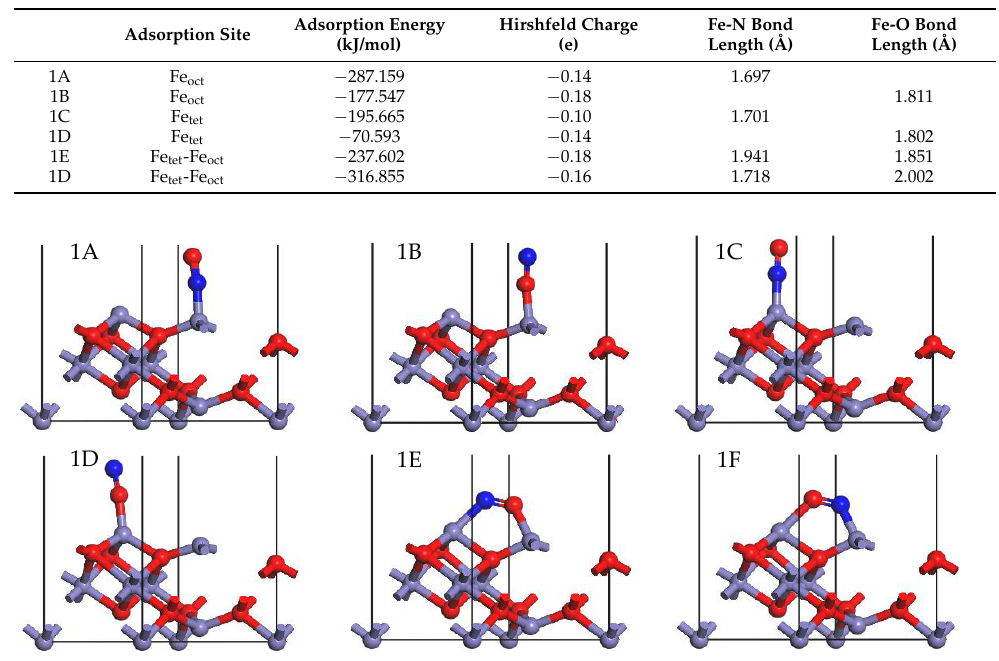
Table 2. The parameters of optimized configurations of the γ -Fe 2 O 3 (111) surface-adsorbed NO molecule.